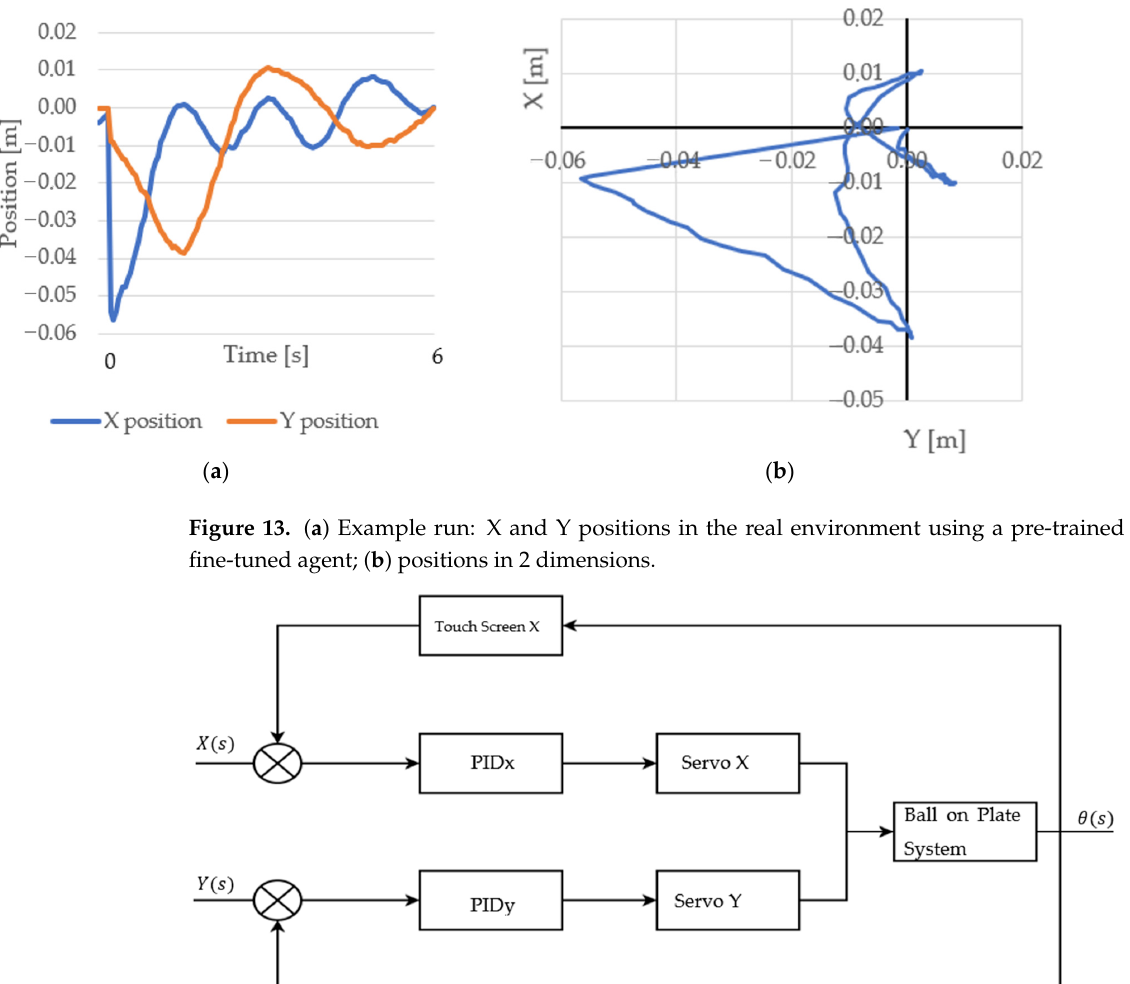
Figure 14. PID control system design.